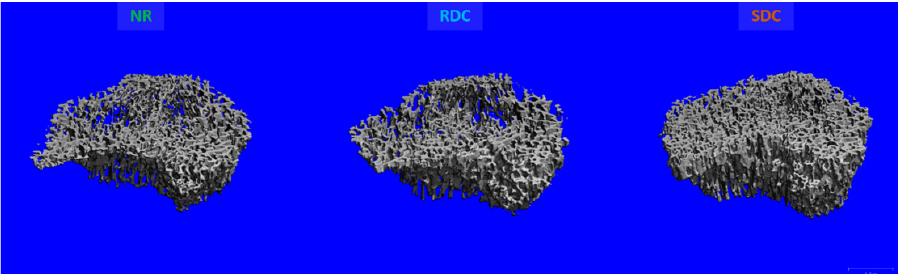
Figure 2. Representative MicroCT images of the tibia trabecular bone after the refeeding period. NR group, not restricted group; RDC group, refeeding with rapid digestible carbohydrates diet; SDC group, refeeding with slow digestible carbohydrates diet. Table 2. Micro-CT trabecular and cortical parameters of tibia and vertebra after refeeding.